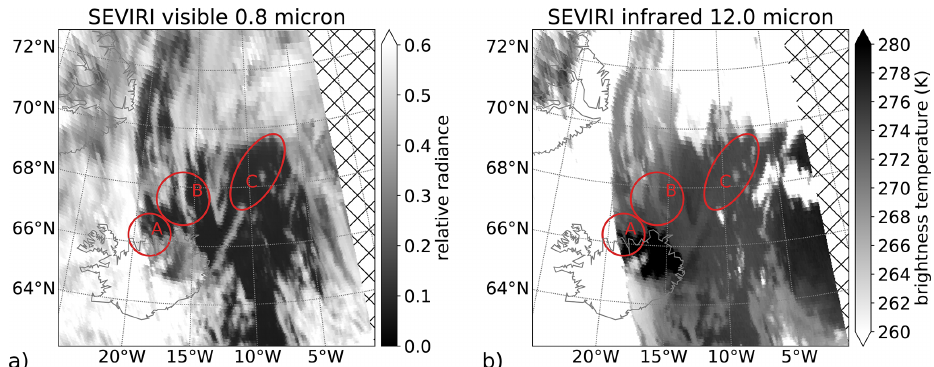
Figure 14. Two images taken by SEVIRI on Meteosat on 18 September 2017 at 12:00UTC. Panel (a) shows the 0.8µm visible channel in a relative scale, and (b) shows the 12.0µm infrared channel as brightness temperature. The three red ellipses mark areas of interest. Hatched areas indicate missing data.